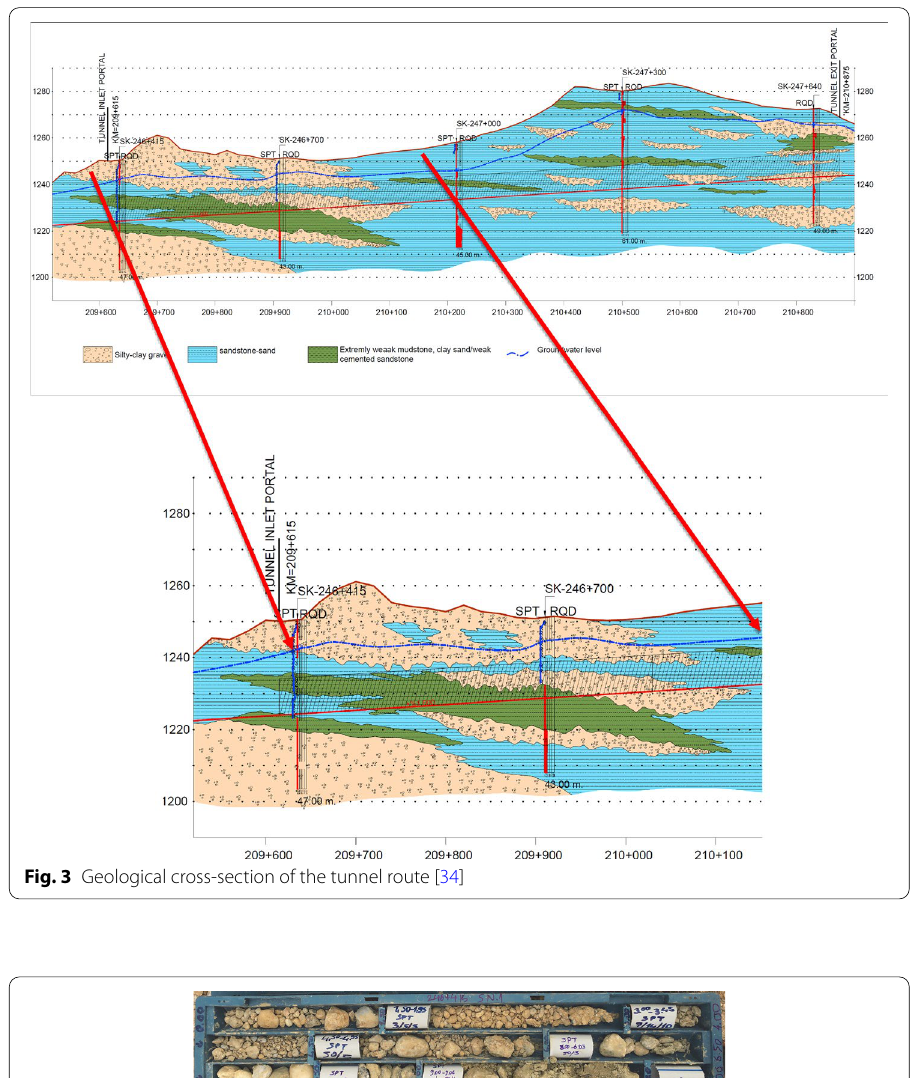
Fig. 3 Geological cross-section of the tunnel route [34]